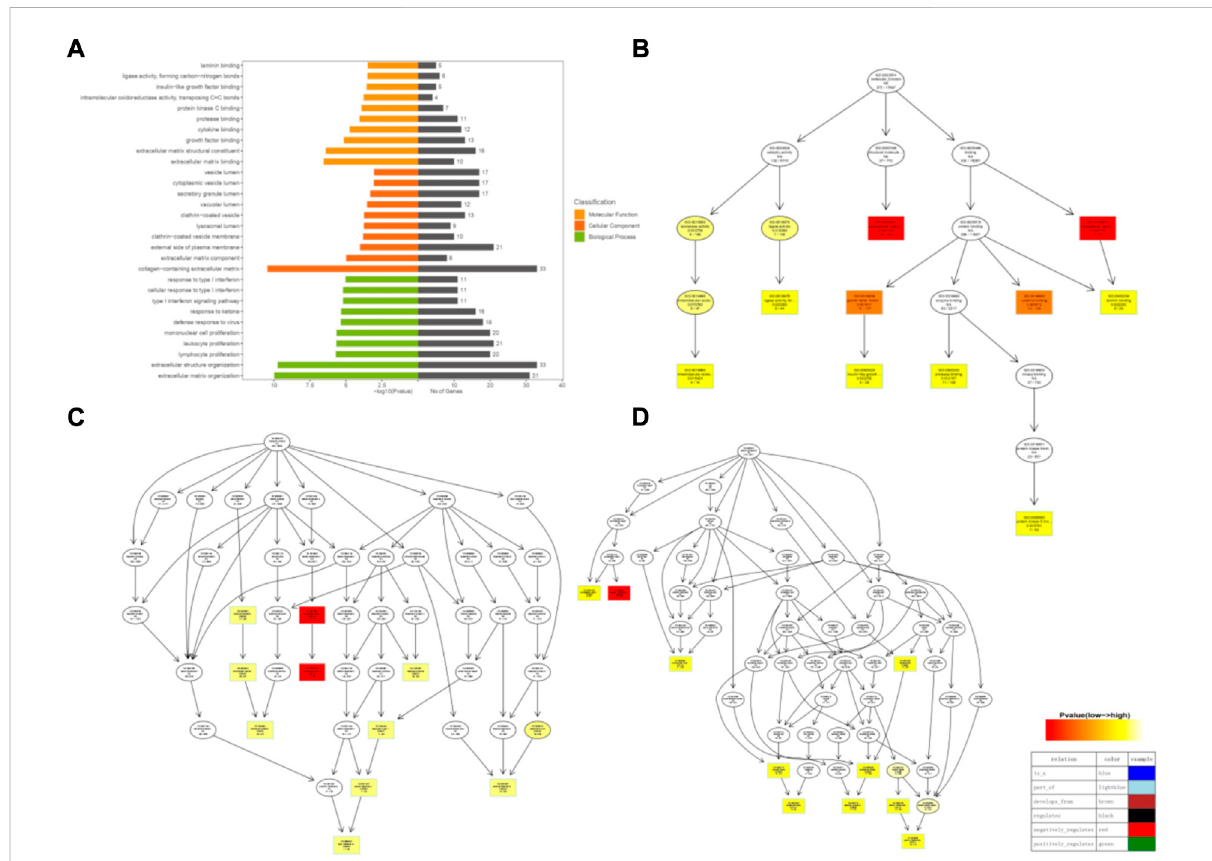
GO enrichment analysis of DEGs. (A) : Differential Gene GO Enrichment Distribution Map. Differential Gene GO Enrichment Directed Acyclic Graph. The darker the color, the higher the enrichment level. (B) GO molecular function analysis; (C) GO biological process analysis; (D) GO cellular component